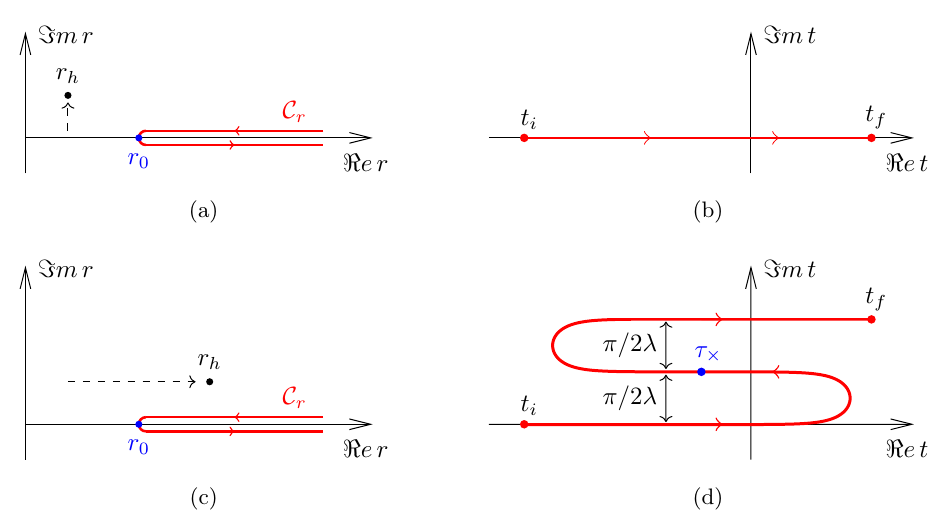
Figure 4 . Trajectory of the particle in complex planes of the radial and temporal Schwarzschild coordinates for the regularized solutions at M < M cr (top) and M > M cr (bottom). The radial coordinate r ( (cid:28) ) varies along the almost real contour as the particle’s proper time (cid:28) changes C r (cid:3)